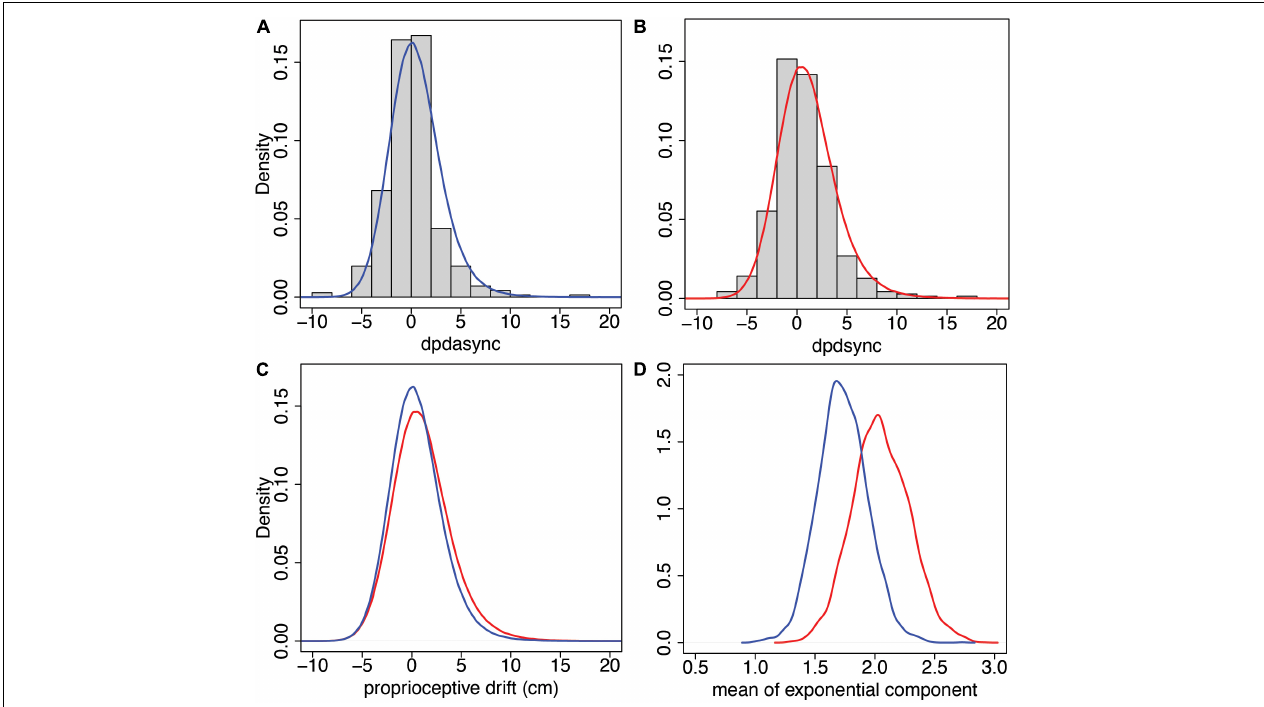
FIGURE 7 | Predictive and posterior distributions for proprioceptive drift from the model of Section “Statistical Model for Proprioceptive Drift” (Eq. 4). (A) The histogram of the observations and predictive posterior for dpdasync . (B) The histogram of the observations and predictive posterior for dpdsync . (C) The predicted posteriors of dpdasync (blue) and dpdsync (red). (D) The posterior distributions of the means of the exponential components for asynchronous (blue) and synchronous (red) conditions.